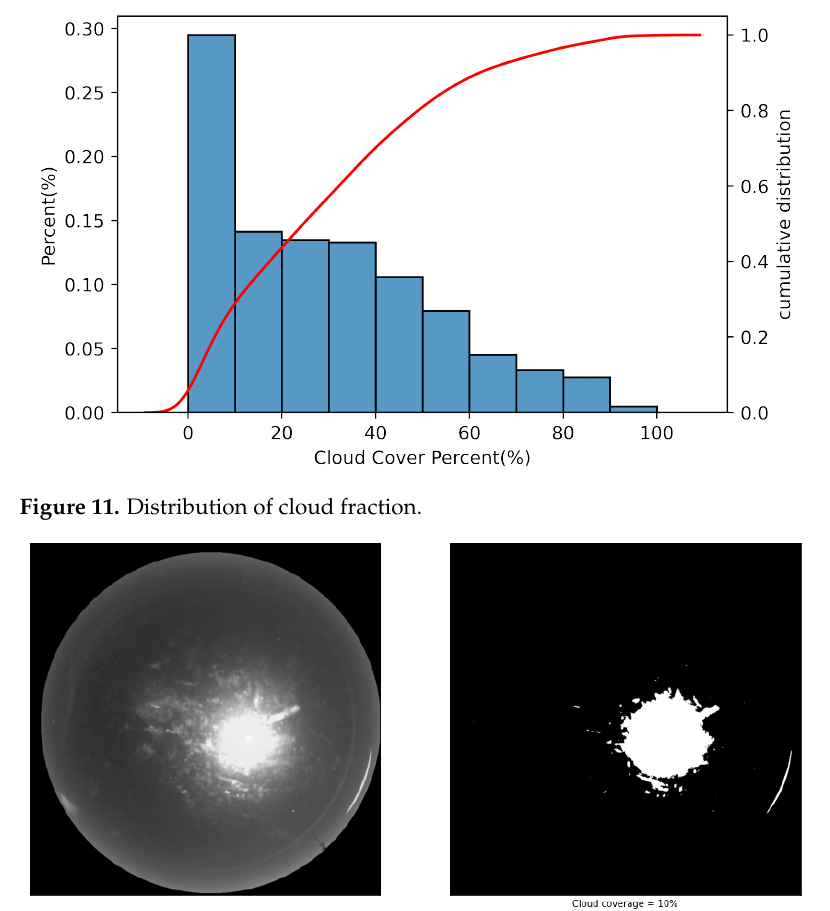
Figure 12. ( Left ) MI taken under clear sky conditions. ( Right ) The binary image, where cloud cover of the Moon area is